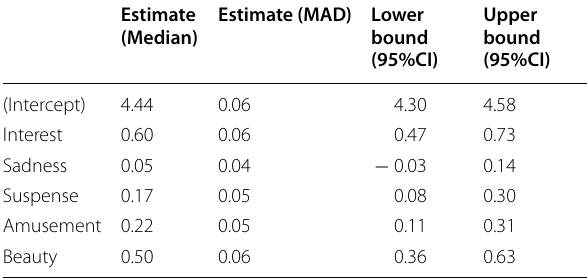
Table 4 Posterior distributions (Median, MAD, 95% CI) of the population-level associations between the components and